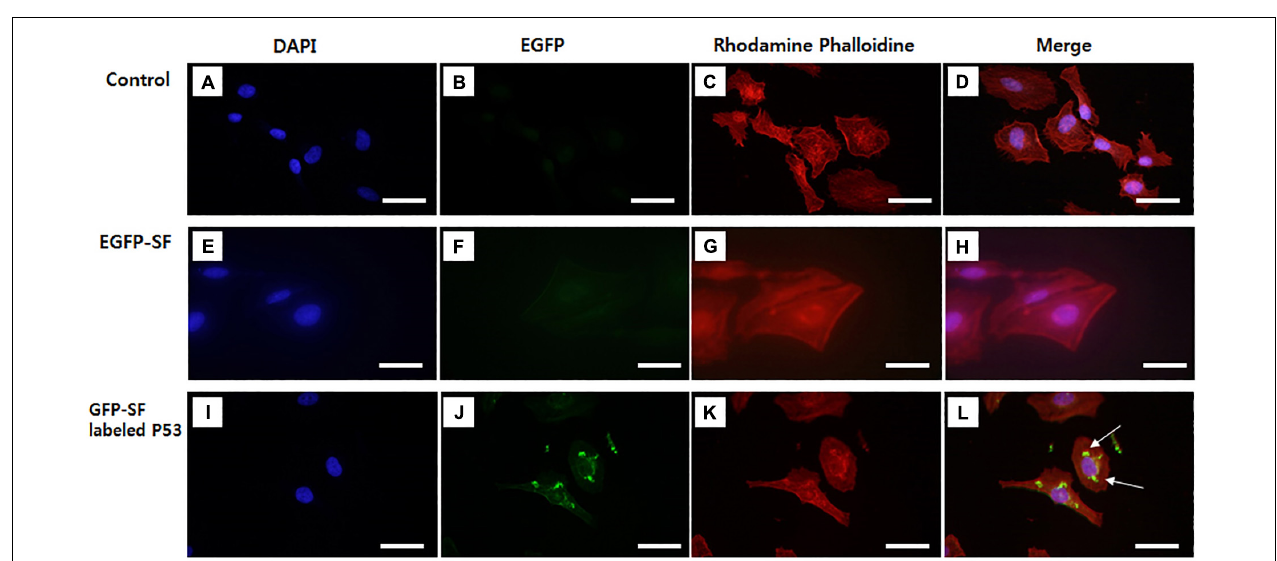
FIGURE 4 | Images of p53 localization using EGFP fluorescent SF labeled p53 antibody in HeLa cell. (A–D) Control, (E–H) EGFP fluorescent SF solution, (I–L) EGFP fluorescent SF labeled p53. HeLa cells were stained with (A,E,I) DAPI and (C,G,K) Rhodamine Phalloidin and imaged under fluorescence microscopy, (D,H,L) DAPI, GFP, and Rhodamine Phalloidin images were merged. White arrows are the image of EGFP-SF labeled P53 in Hela cell. Scale bar = 50 µ m. Not published.